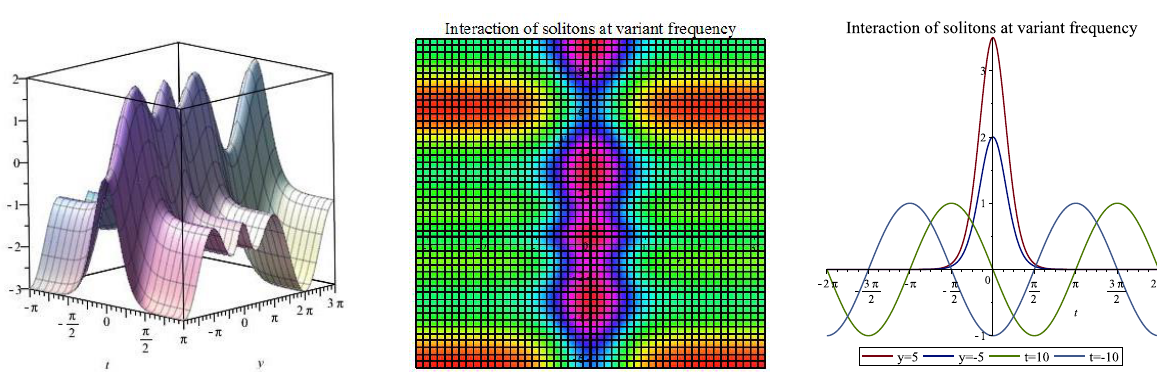
Figure 4. Wave profile depiction of soliton interaction with different amplitudes, frequency and also propagating along the same direction when variable x = 0.